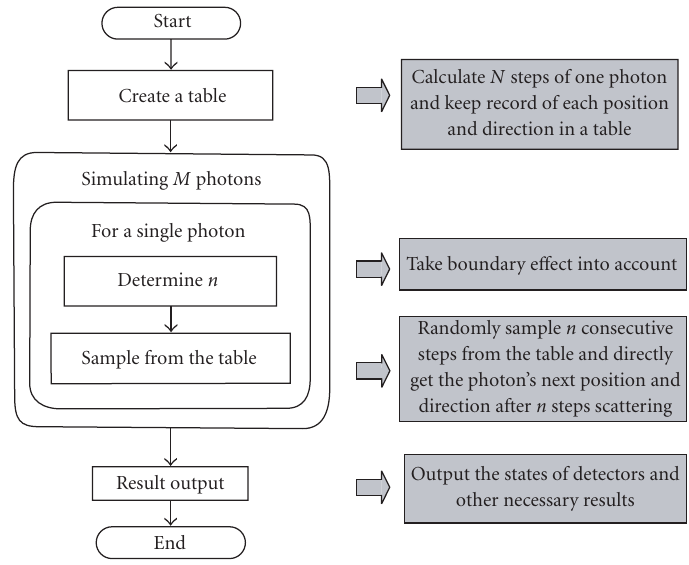
Figure 2: The flowchart to show the algorithms of TBRS method. Assuming a single-photon transport N steps from the initial position, we calculate and record the position and direction of each step in a table. M is the total number of photons used in a